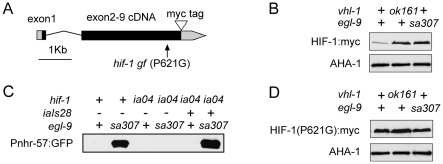
Characterization of the hif-1 and hif-1(P621G) transgenes.(A) Diagram of the minigenes that express epitope-tagged HIF-1. Genomic sequence including the hif-1 promoter sequence, exon 1, and intron 1, was fused to cDNA including exons 2–9 for the predominant hif-1 mRNA isoform (hif-1a). A myc epitope tag was inserted. A proline to glycine conversion at amino acid residue 621 prevents VHL-1-mediated degradation [17]. (B) Representative protein blots show that epitope-tagged HIF-1 is stabilized by loss-of-function mutations in vhl-1 or egl-9. AHA-1 is ortholgous to HIFβ/ARNT [48], and the abundance of AHA-1 does not vary significantly in these strains. (C) Western blots show the transgene restores HIF-1-mediated gene expression. Pnhr-57:GFP is a reporter for HIF-1 activity [20]. Its expression is dramatically reduced in hif-1(ia04) mutants and is restored by the iaIs28 integrated hif-1 transgene. (D) Oxygen-dependent degradation via the vhl-1/egl-9 pathway is abolished when the HIF-1 proline residue 621 is mutated to glycine.